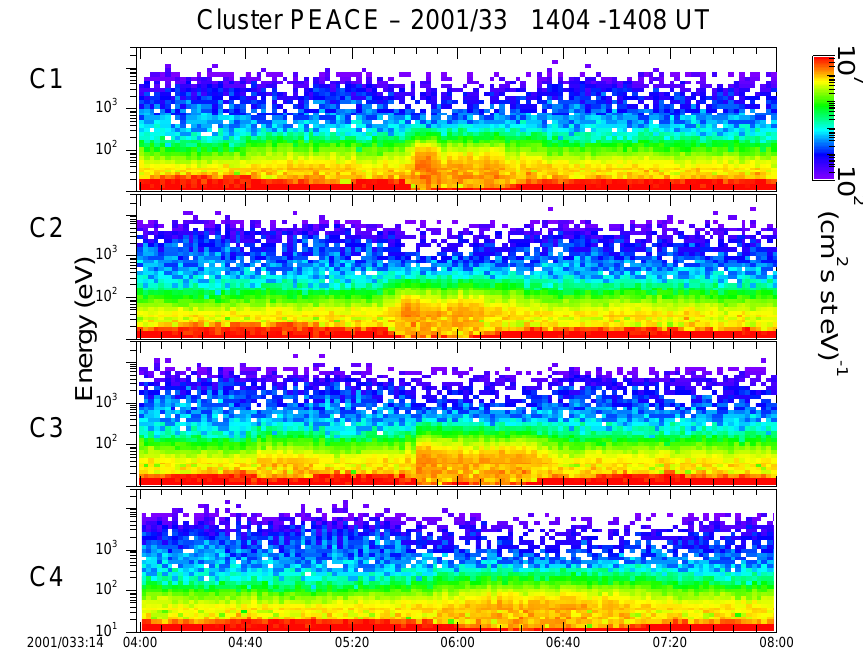
Fig. 4. PEACE energy-time spectrograms for the period from 14:04–14:08 UT on 2 February 2001, a period covering the observation of a burst of magnetosheath electrons. On this reduced time scale, the differences between the signatures observed at the individual spacecraft are apparent. C1, C2 and C3, located closest to the magnetopause, observe a sharp onset, with the C2 signature leading the other 2 by a few seconds. Conversely, the C4 signature is significantly delayed, and has a longer duration but is less intense and less structured.